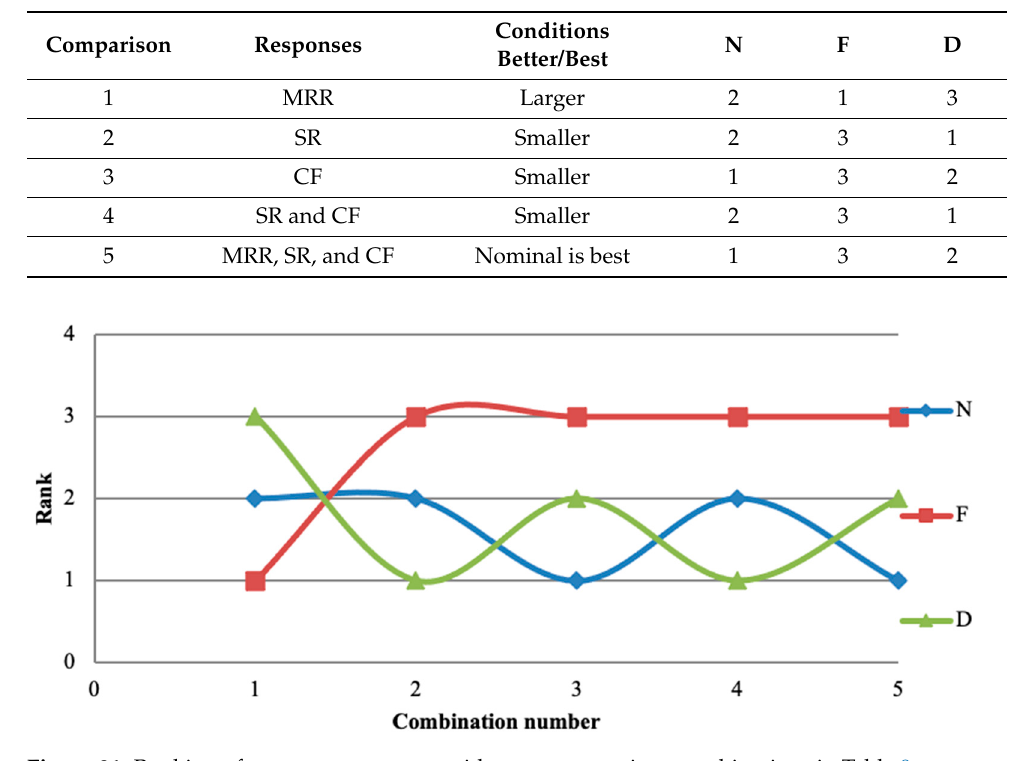
Figure 31. Ranking of process parameters with respect to various combinations in Table 9.